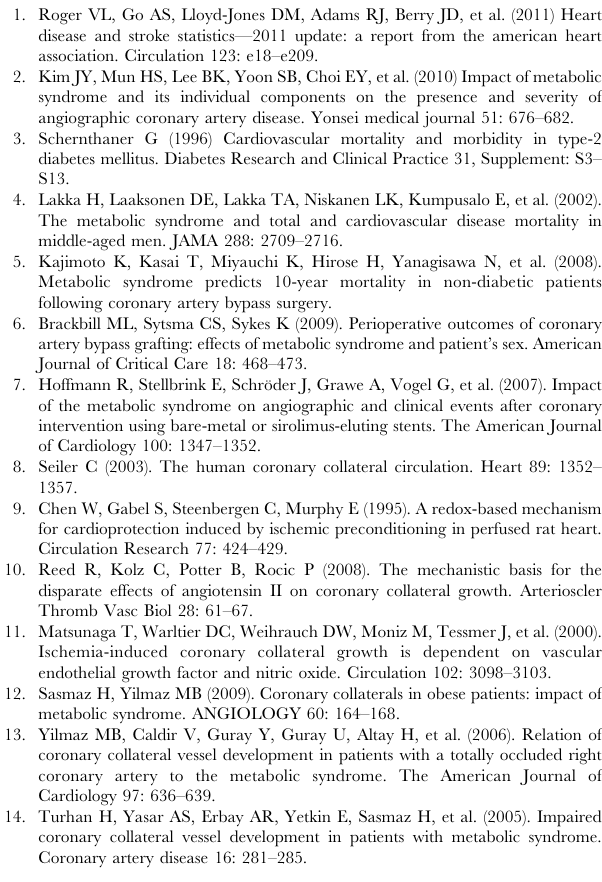
Figure S1 Labview back panel. The main portion of the software consists of a series of ‘‘filmstrip’’ timing loops, indicated by the thick lines with squares. Table S1 Table of parts required to build the automated balloon catheter